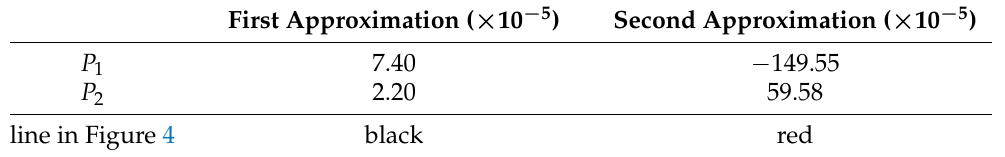
Table 4. Polynomials